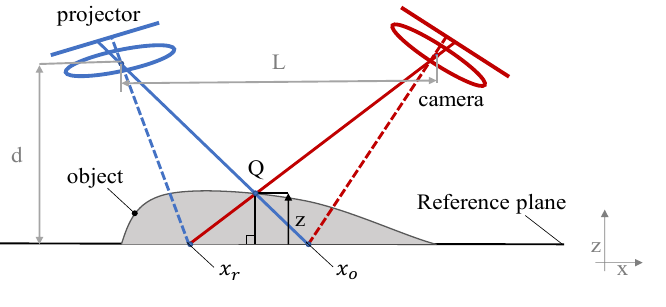
Figure 1. The principle of PMP.